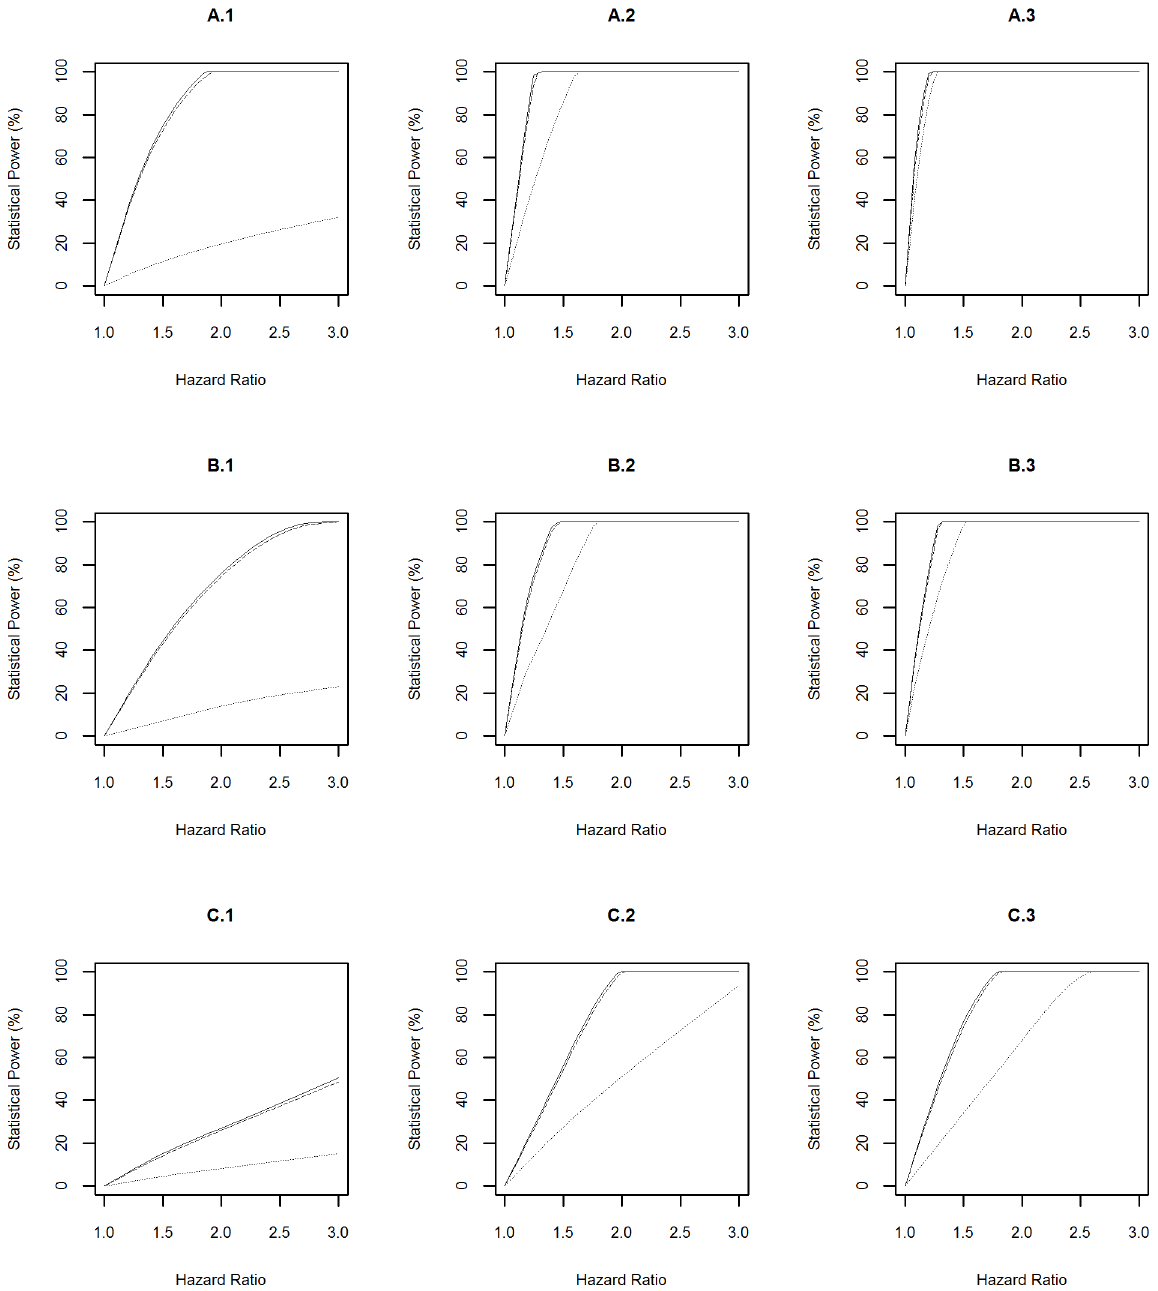
Fig 2. Power Profile at Significance Level of 0.05 for Environmental Risk Exposure. “ A ” , “ B ” and “ C ” represent diabetes, dementia and Parkinson ’ s disease respectively. “ 1 ” , “ 2 ” and “ 3 ” represent rare (prevalence = 0.01), common (prevalence = 0.1), and very common (prevalence = 0.2) environmental risk exposures respectively. The solid, dashed and dotted lines represent the statistical power profile of the study assuming subjects undergo health monitoring continuously, subjects undergo repeated measures every three years, and subjects undergo repeated measures every three years and the environmental risk exposure is measured with a misclassification rate of 0.1